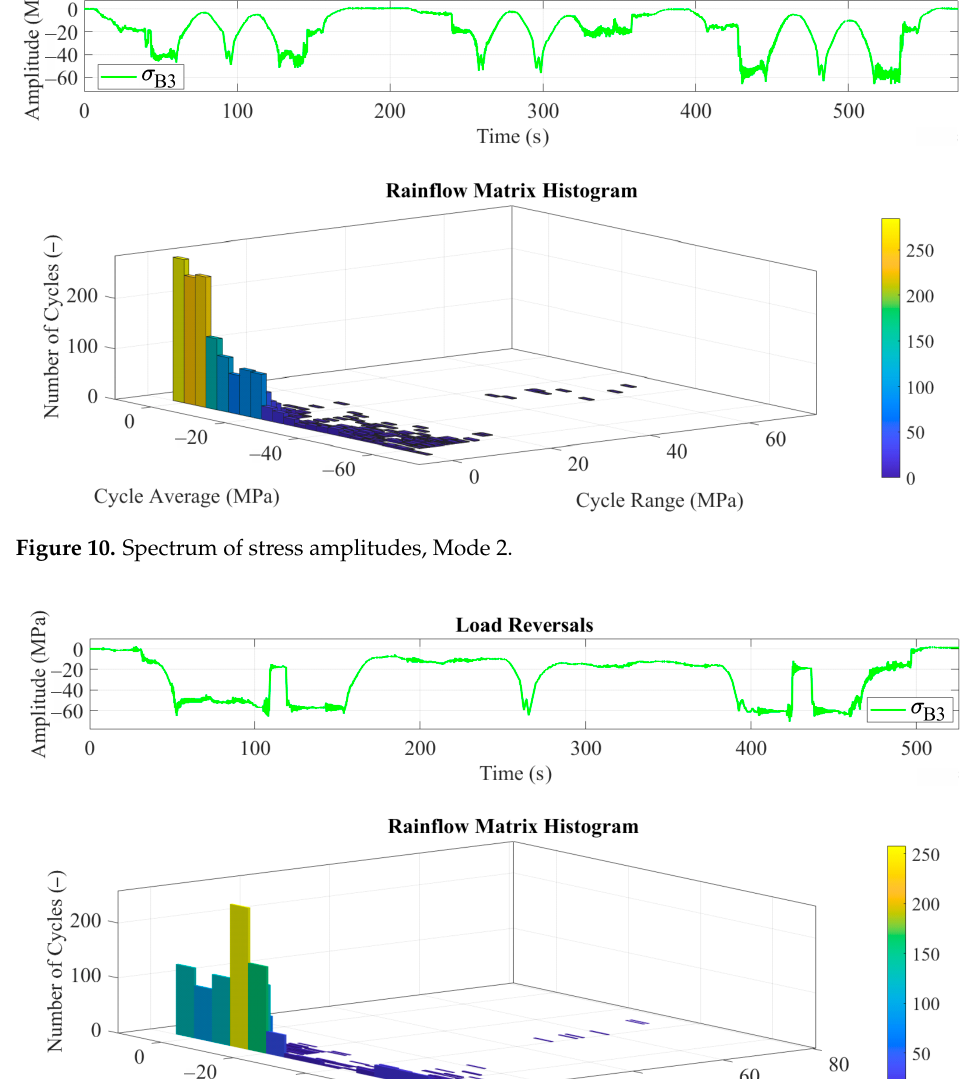
Figure 9. Spectrum of stress amplitudes, Mode 1.